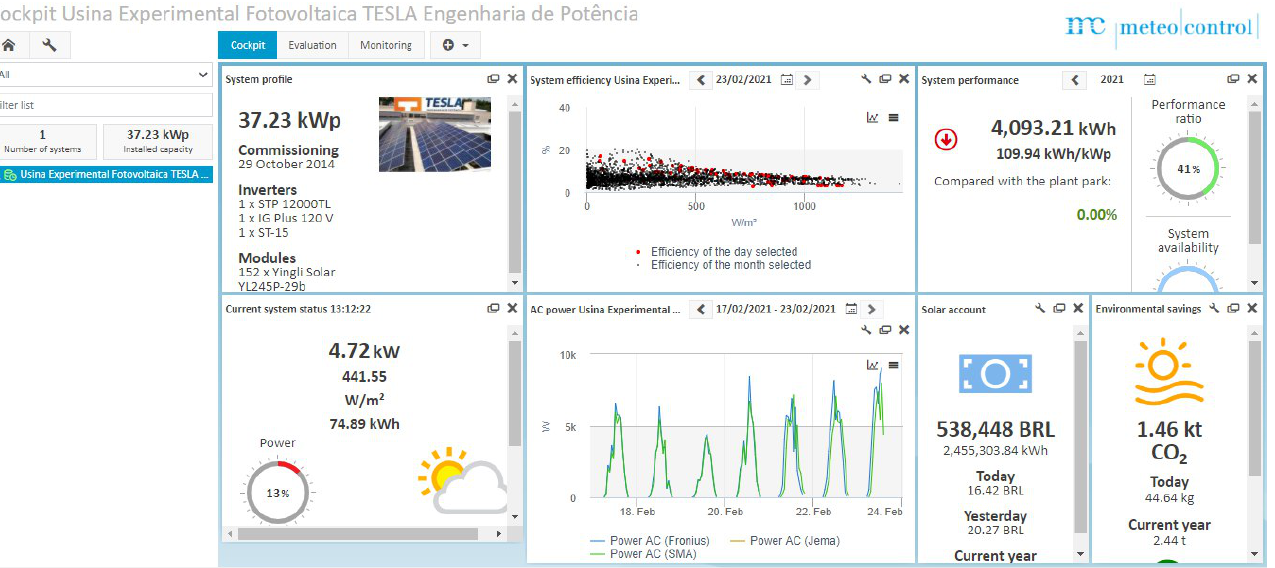
Figure 13. Main screen of the commercial supervisory